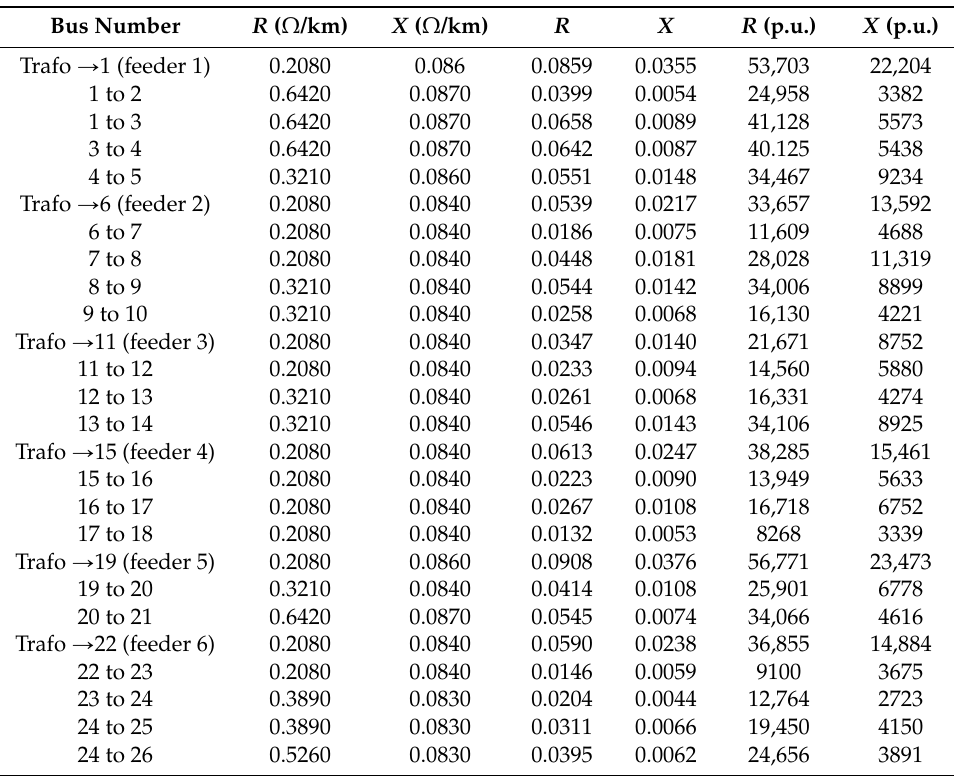
Table A2. Data of grid